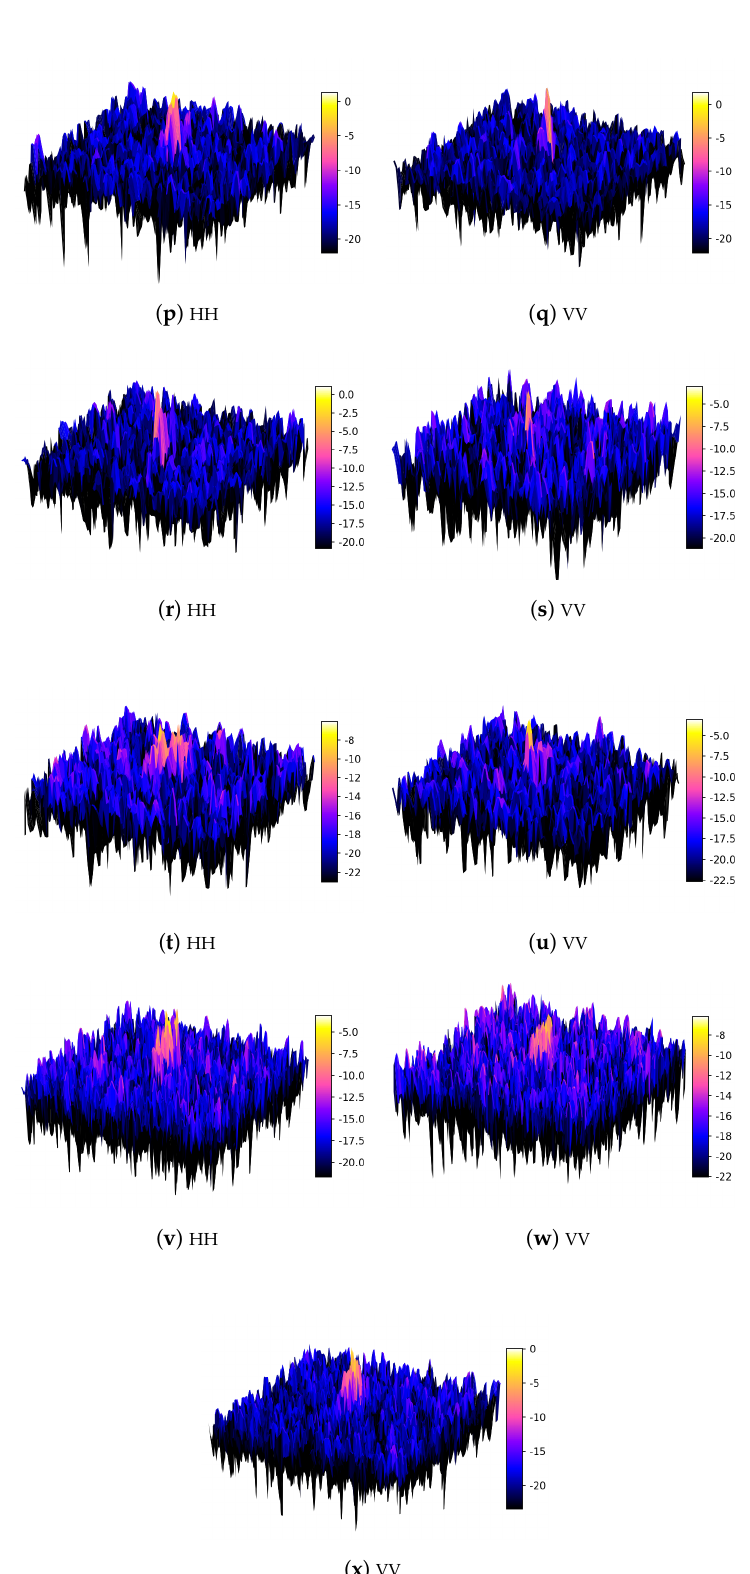
Figure 8. 3D representations of the vessel’s radar footprint in TSX-HS mode (©DLR, 2017) with indications for polarization and special scene or sensor